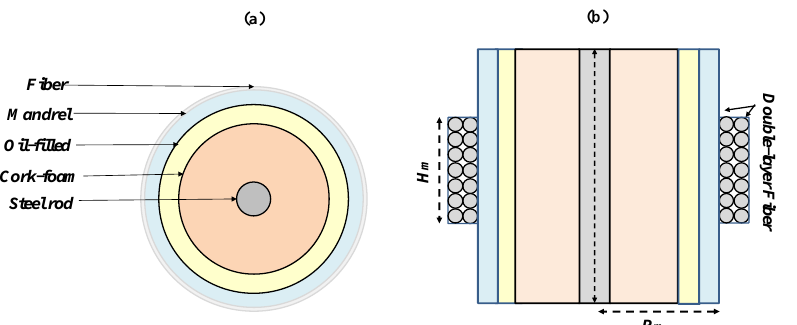
Figure 16. The composite FOH ( a ) horizontal cross-section and ( b ) lateral view. Reproduced with permission from ref [71], the figure is released under a Copyright Clearance Center ’ s RightsLink ® service).